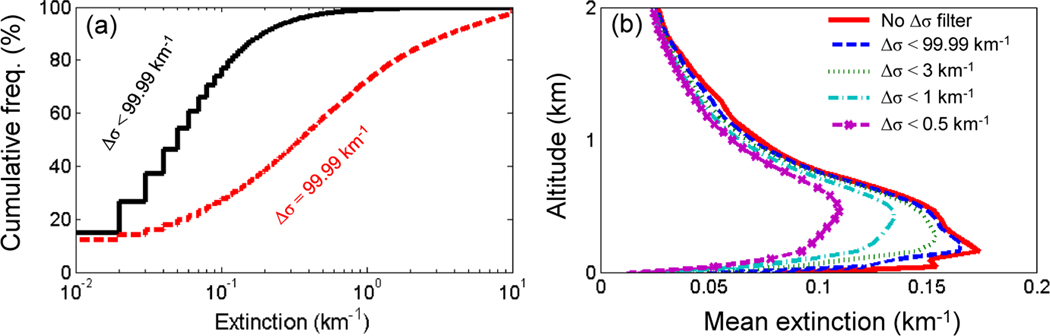
(a) Cumulative frequency distributions of level 2 σ where Δσ ≠ 99.99 km−1 (black) and ≠ Δσ = 99.99 km−1 (red) for August 2007; (b) level 3 σ¯ profiles without the Δσ filter (red) and with varying upper limits on the Δσ filter threshold (dashed lines) for the mid-Atlantic Ocean, 2007, all-sky at night.